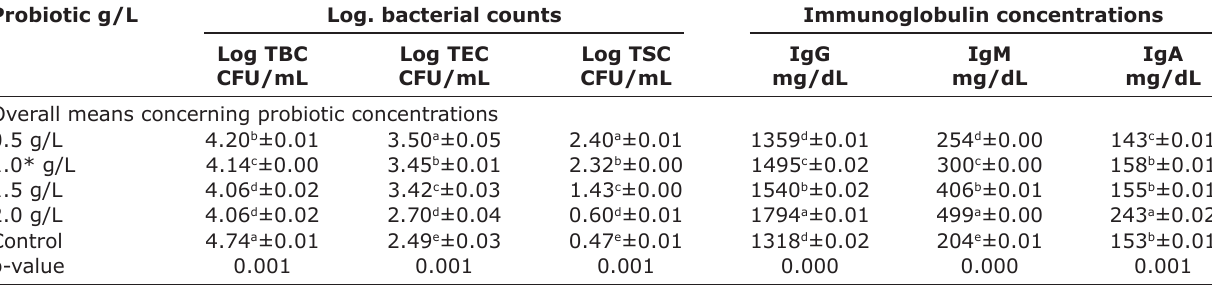
Table-4: Logarithmic bacterial counts (mean±SE CFU/mL) and Immunoglobulin concentrations (mean±SE mg/dL) in broilers supplemented with different concentrations of probiotics. Probiotic g/L Log. bacterial counts